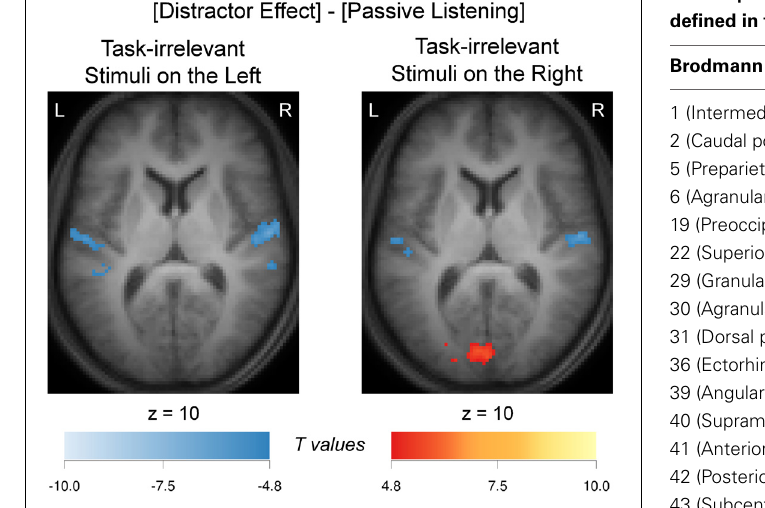
FIGURE 5 | Distractor effect and passive-listening comparison. Supra-additivity (sub-additivity) resulting from comparison of averaged distractor activation maps ( Figure 4C ) and passive listening ( Figure 4A ), that is ([( Concordant + Discordant + Non-Letter )/3— No-Distractor ] vs. No-Task ), when these task-irrelevant stimuli were presented on the left ear and on the right ear. Images were thresholded at a confidence level p < 0 . 05 (FWE-corrected). Supra-additivity (sub-additivity) of nine adjacent slices were overlaid over the mean anatomical image over all subjects. Hot (cold) colors refer to increased (decreased) signals. L, left; R, right.